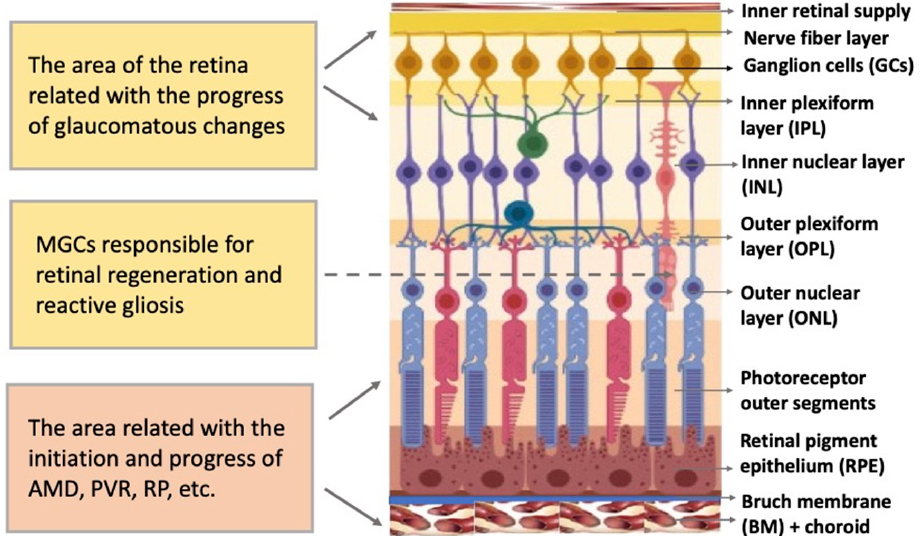
Figure 2. Structure of the retina and retinal compartments involved in degenerative diseases. MGCs—Müller glial cells, AMD—age-related macular degeneration, PVR—proliferative vitreoretinopathy, RP—retinitis pigmentosa .